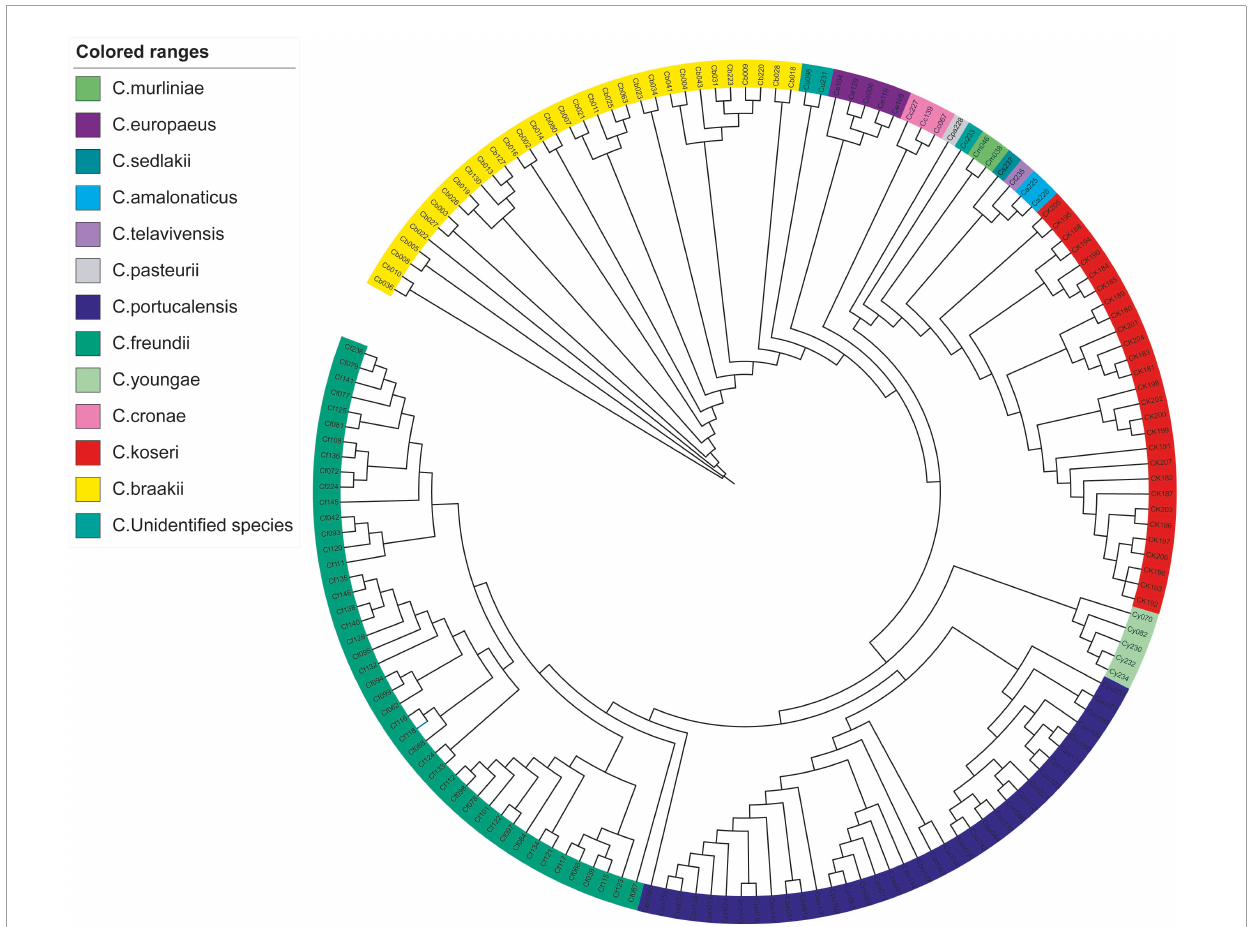
FIGURE1 Whole-genome SNP phylogeny of Citrobacter spp. A phylogenetic tree of 164 Citrobacter spp. isolates was constructed based on whole-genome SNP using